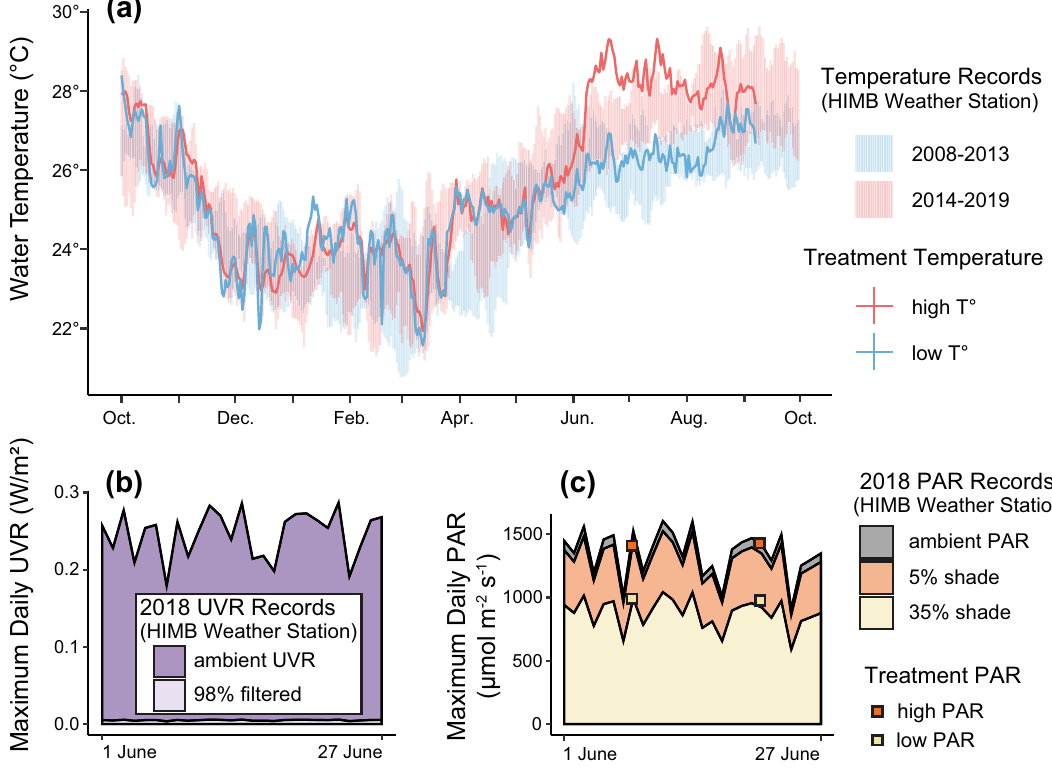
Figure 2. ( a ) Seawater temperatures in the high and low temperature treatments (solid lines) approximately following modern temperature records (2014–2019, includes two bleaching events) and historical temperature records (2008–2013) from the Moku o Lo ʻ e weather station (lighter coloured ranges). ( b ) Ultraviolet ranges in the ambient UVR and 98% blocked UVR treatments visualised here for the month of June 2018, based on records from the Moku o Lo ʻ e weather station. ( c ) Photosynthetically active radiation measurements for the month of June 2018 in the high and low PAR treatments (solid boxes), representing 5% and 35% shading of ambient PAR levels, respectively. Upper line (in grey) represents ambient PAR levels recorded at the Moku o Lo ʻ e weather station. The light orange and light yellow lines are calculated as 5% and 35% less than ambient levels, matching the shading levels in our PAR